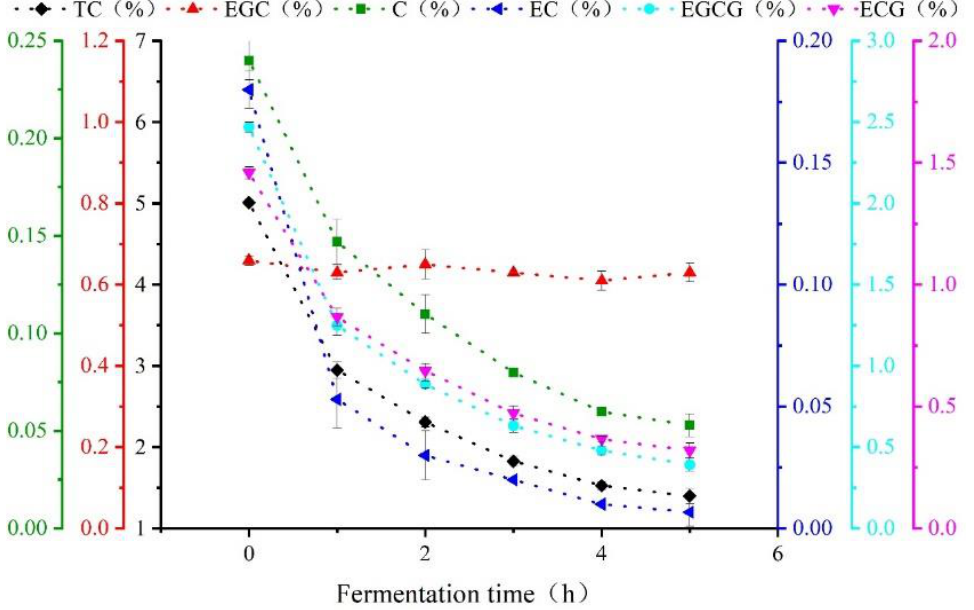
Figure 2. Change trends of catechin component content during Congou black tea fermentation.